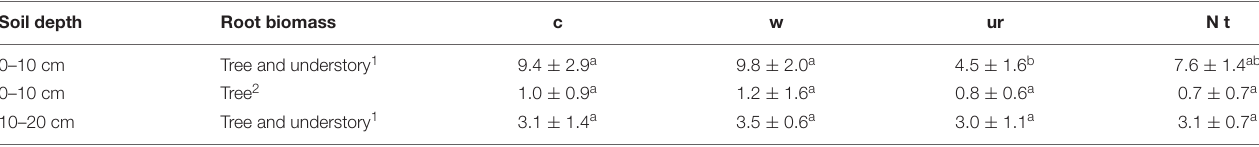
TABLE 5 | Total (tree and understory) and tree fine-root biomass (g dw l − 1 soil); (Mean ± SD) in 0–10 cm and 10–20 cm soil depth in control (c), warmed (w), understory removal (ur) and N fertilized (N) blocks at the end of the growing season 2013. Soil